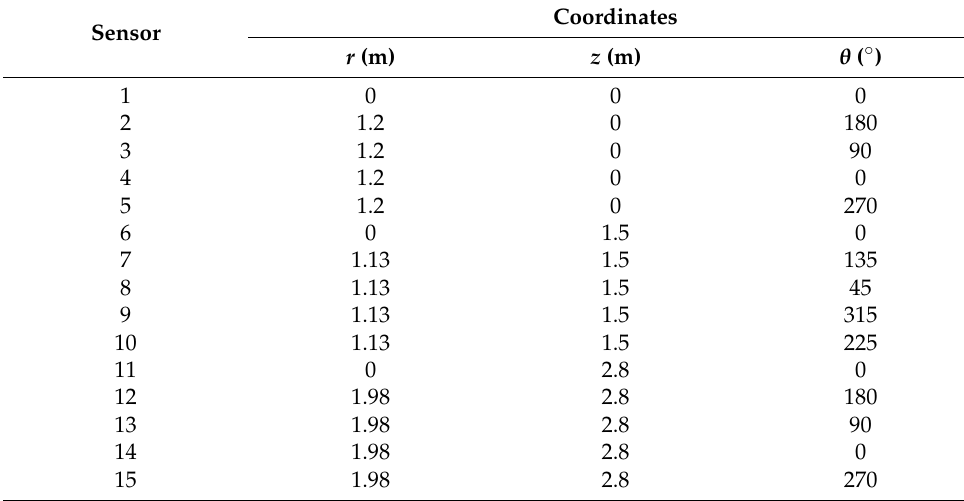
Figure 2. ( a ) Boundary conditions and industrial ladle dimensions (in m), ( b ) three-dimensional sensor distribution (positions masked as asteriks), and ( c ) computational mesh. Table 2. Spatial sensors